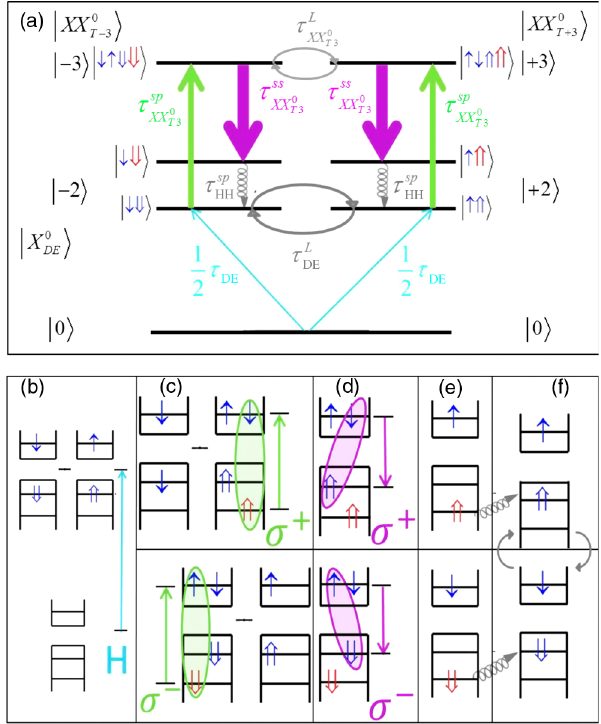
TRSFIG. 3. Schematic description of the experimental steps. (a) The energy levels and optical transitions of the DE-biexciton system are shown schematically. The colors of the arrows correspond to those used in Fig. 1. The width of the arrow represents the strength of the optical transition, with thicker arrows correspond- ing to stronger dipole moments. Nonradiative transitions are indicated by gray arrows. Curly gray downward arrows indicate nonradiative relaxations, and the curved gray arrows represent coherent precession. The various energies and rates are listed in Table I. (b) An H -polarized resonantly tuned laser pulse excites the DE in its antisymmetric eigenstate. (c) A left-hand (bottom panel ) or right-hand (top panel) circularly polarized laser pulse, resonantly tuned to the higher-energy optical transition of the XX 0 biexciton (green upright arrow in Fig. 1) is used to probe T (cid:1) 3 the state of the DE. (d) Detecting a left (bottom panel) or a right (top panel) circularly polarized photon from the lower-energy optical transition of the XX 0 ( XX 0 , top) biexciton heralds the T − 3 T þ 3 presence of a DE in a j − 2 i (lower panel) or a j þ 2 i (upper panel) coherent state. (e),(f) The heavy hole relaxes to the ground rightmost column where PL stands for line ’ s intensity ratio, TRS state via a fast spin-preserving relaxation, leaving a ground-state for pump-probe time-resolved spectroscopy, g ð 2 Þ for intensity DE in the correlation measurements, and RECPM for resonantly excited circular-polarization memory measurements.